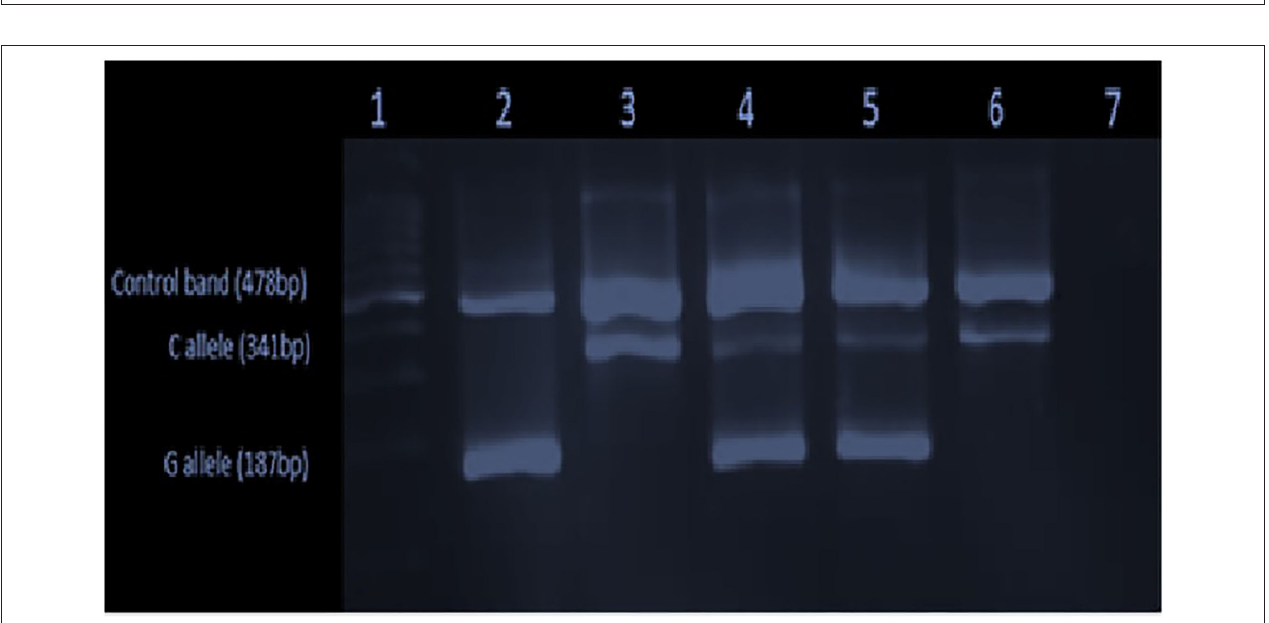
FIGURE 1 | Gel image showing the p.C282Y [c.845G > A] mutation: Lane1-L6 – 100 bp ladder in the 1st lane, homozygote for wild type (GG) in the 2nd lane, the homozygote for mutant A allele in (AA) the 3rd lane, heterozygous for the mutant allele (GA) in the 4th lane and the negative control (GG) and the blank in the 5th and 6th lanes, respectively.